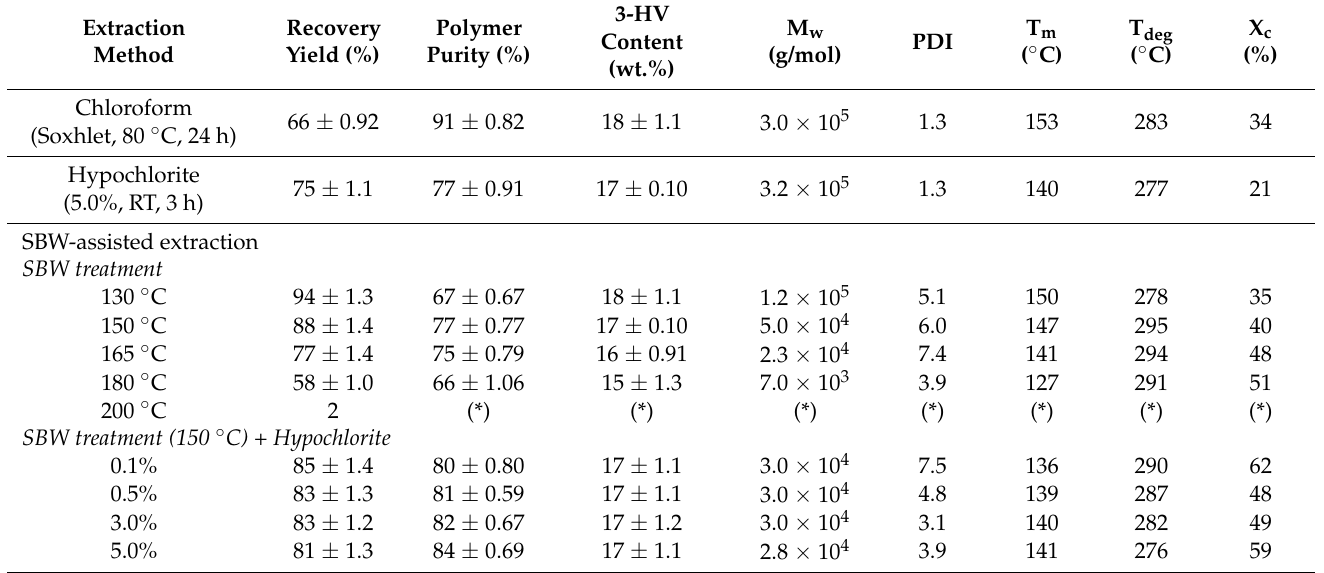
Table 1. Thermal properties and molecular mass distribution of the samples obtained with the different extraction methods tested (T m , melting temperature; T deg , degradation temperature; M w , average molecular weight; PDI, polydispersity index; X c , crystallinity index; 3HV, 3-hydroxyvalerate; RT, room